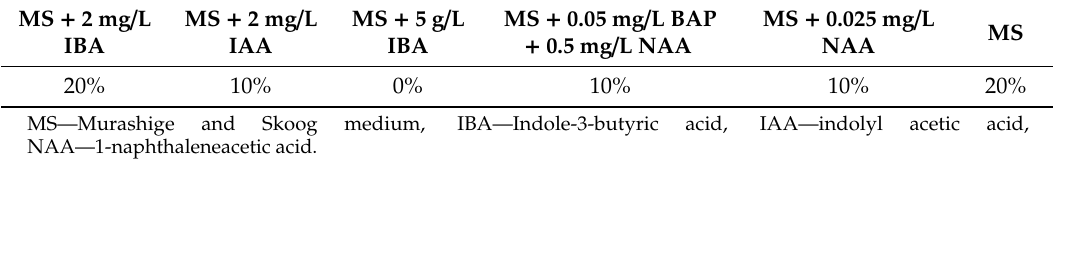
Table 3. Percentage of rooting of Artemisia hololeuca in a variety of